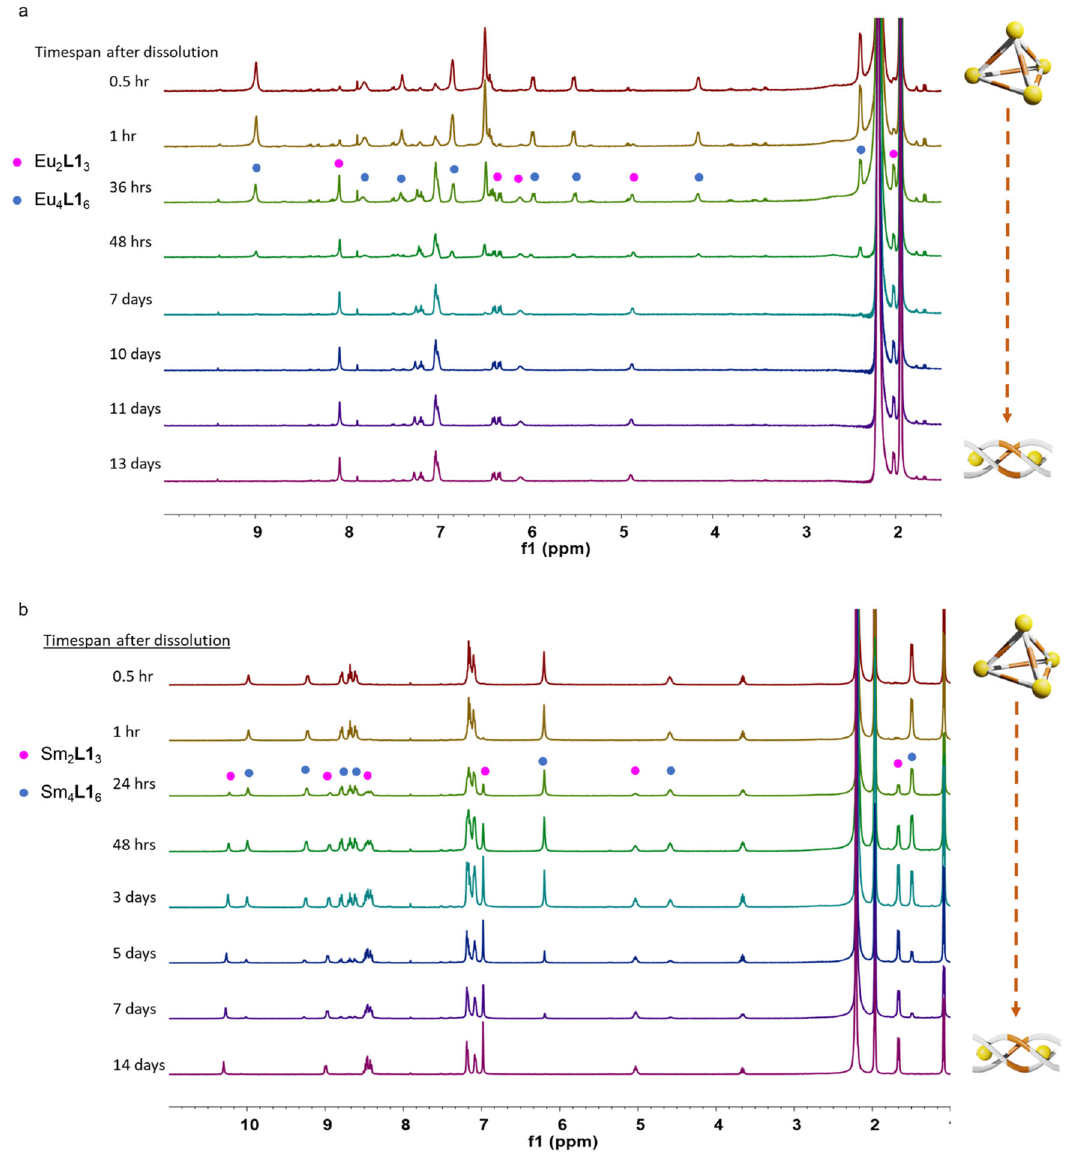
Fig. 5 1 H NMR spectrum of the tetrahedron-to-helicate transformation. a Tetrahedron-to-helicate transformation from [Eu 4 L1 6 ] to [Eu 2 L1 3 ] (4.53 × 10 − 4 M in CD 3 CN). [Eu 4 L1 6 ] slowly rearranged back to [Eu 2 L1 3 ] after dilution in CD 3 CN for 11 days. b Tetrahedron-to-helicate transformation from [Sm 4 L1 6 ] to [Sm 2 L1 3 ] (4.12 × 10 − 4 M in CD 3 CN) (bottom) upon dissolution in CD 3 CN. [Sm 4 L1 6 ] slowly rearranged back to [Sm 2 L1 3 ] after dilution in CD 3 CN for 14